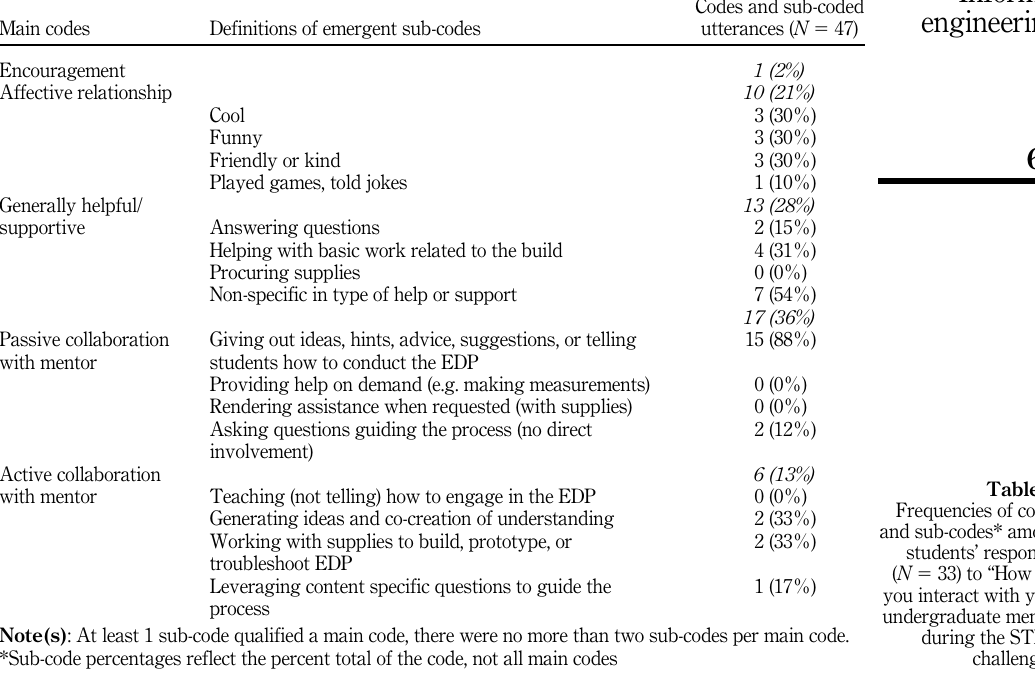
Table 5. Frequencies of